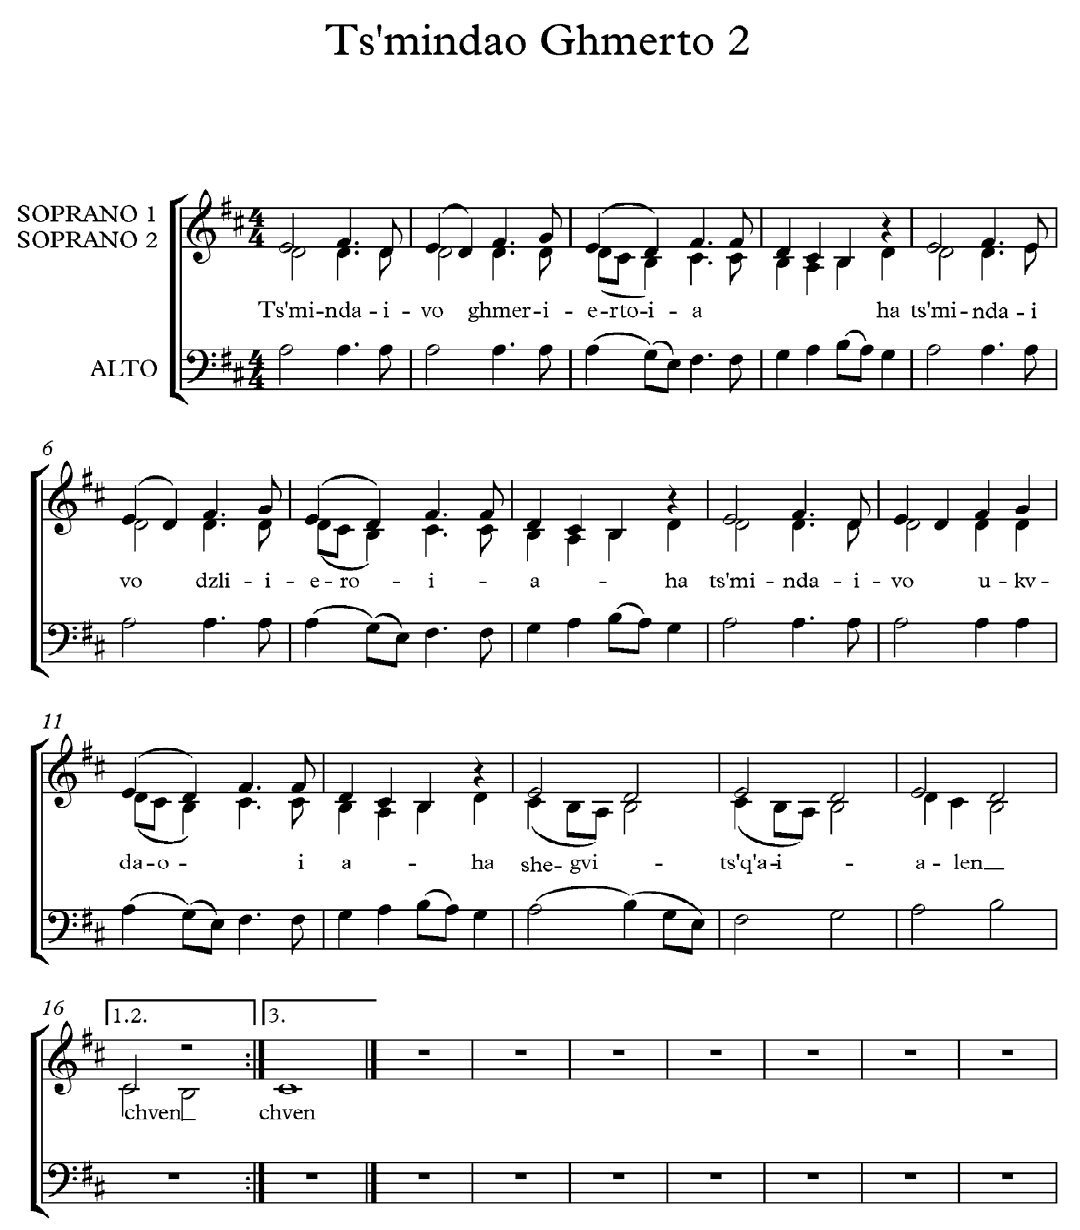
Figure 7. Trisagion; plain mode; Upper Svan variant, Lakhushdi Village.